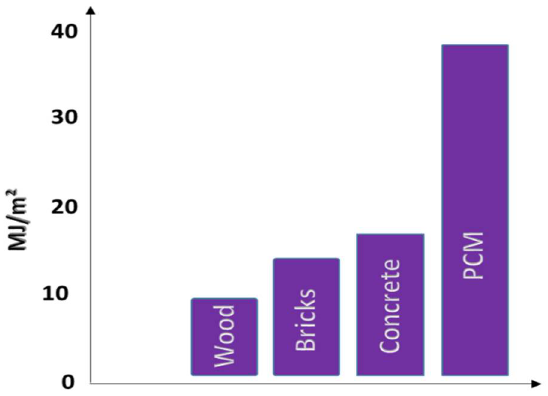
Figure 2. The energy storage density (for a material heating from 20 °C to 26 °C).